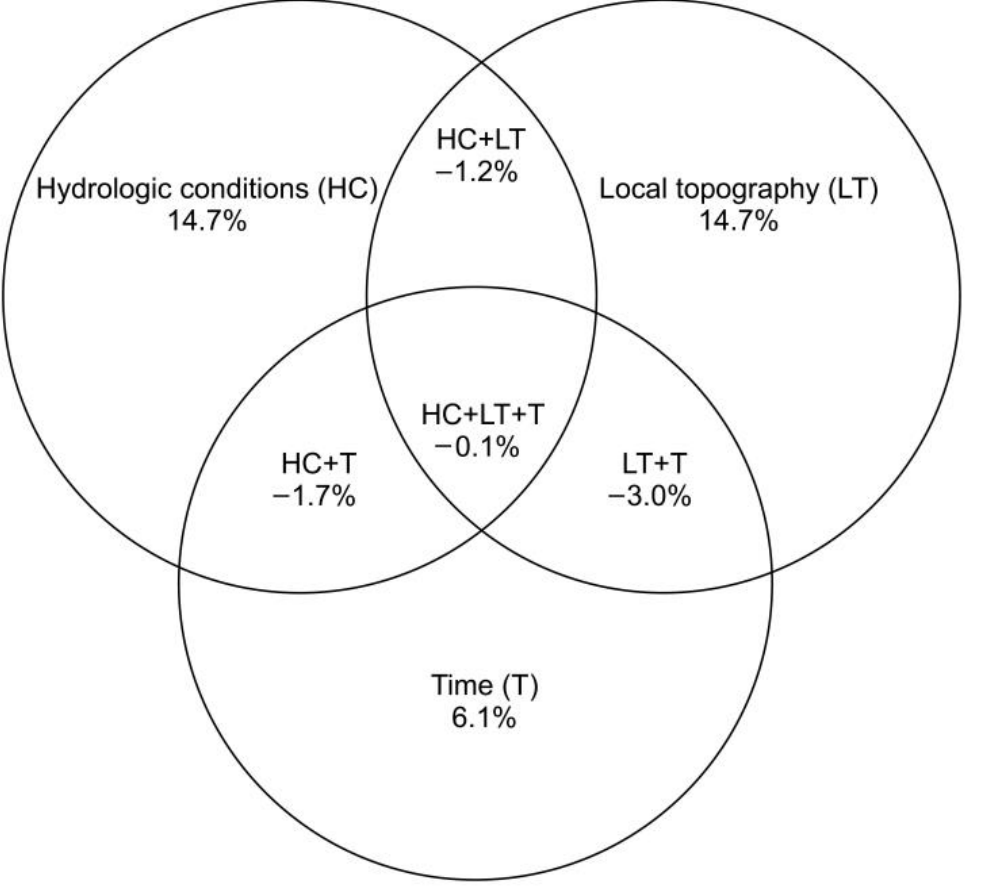
Figure 2. Venn diagram showing overlap of hydrologic changes (HC), local topography (LT) and time (T) based on earthworm community composition in mountain fens. Community composition fit with earthworm species abundance data; variation partitioning based on pRDA analysis. Our results also showed that all canonical RDA axes, constrained by HC, LT and time, explained 32.6% of the earthworm community composition variance in mountain fens ( λ trace = 0.326, F = 2.363, p = 0.002). However, partitioning the variation into time (using HC and LT as covariates) indicated a non-significant effect of time (season and year of study) on the earthworm community composition variation ( λ trace = 0.061, F = 1.316, p = 0.176). The overlap between models (shared variation) was low and gave negative values, indicating that the effect of HC and LT together was stronger than the sum of the two separate effects [57,58]. Forward stepwise selection of the environmental